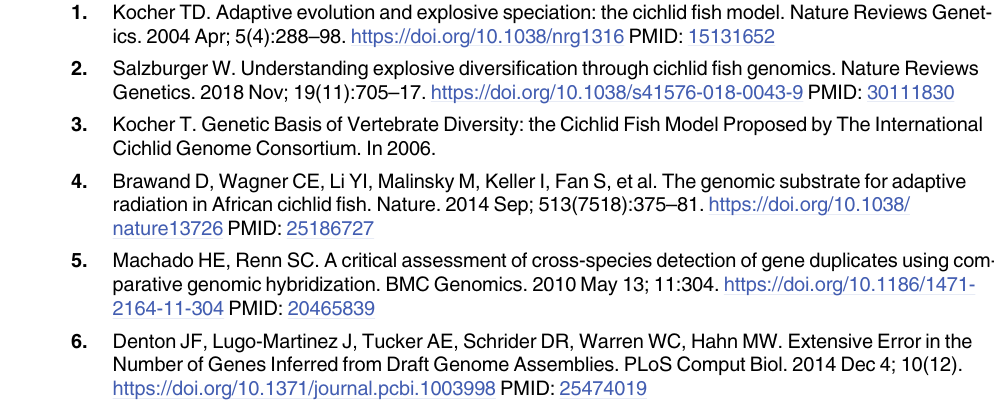
S2 Fig. Nucleotide composition PCA for platform-exclusive probes. Principal component analysis (PCA) plots representing distributions of probes detected as gains in either M . zebra or O . niloticus by only one of three platforms. Panel (A) shows PCs 1 and 2 and panel (B) shows PCs 2 and 3. Contribution of all nucleotide composition statistics are superimposed on each plot to visualize potential platform biases. While all platform-exclusive probe sets largely overlap, probes with higher G/C content appear more likely to be detected as gains in PacBio assemblies than by Illumina or aCGH along PC1. Additionally, aCGH-exclusive probe sets have slightly higher A-content than either sequencing platform exclusive set as represented by PC2 and PC3.